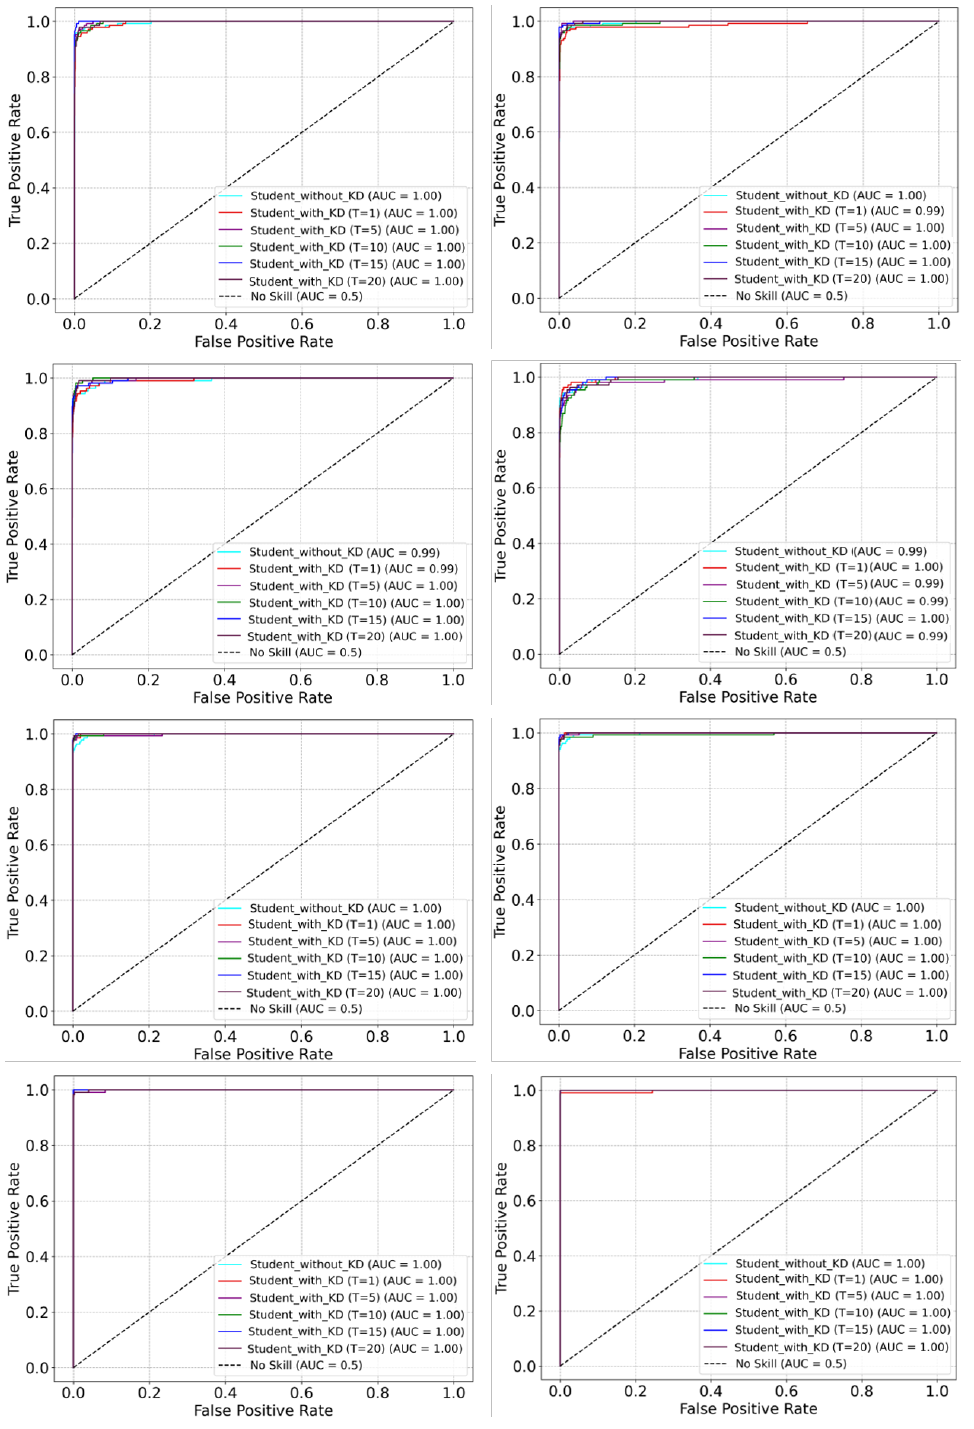
Figure 6. The receiver operating characteristics (ROC) curve graphs of our proposed 3DCNN student model for UCF11, HMDB51, UCF50, and UCF101 datasets. First column represents the ROC curve graphs of the proposed 3DCNN student model distilled with the the TFS teacher model, whereas the second column represents the ROC curve graphs of the proposed 3DCNN student model distilled with the TUTL teacher